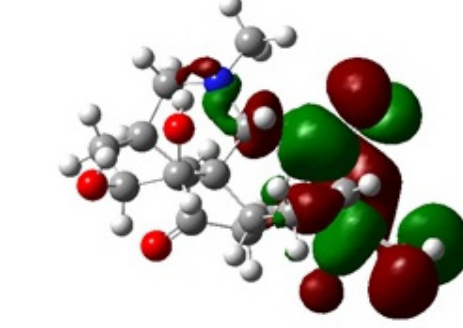
Figure 6. HOMO-LUMO of Compound 1 calculated at B3LYP/6-31þG (p).